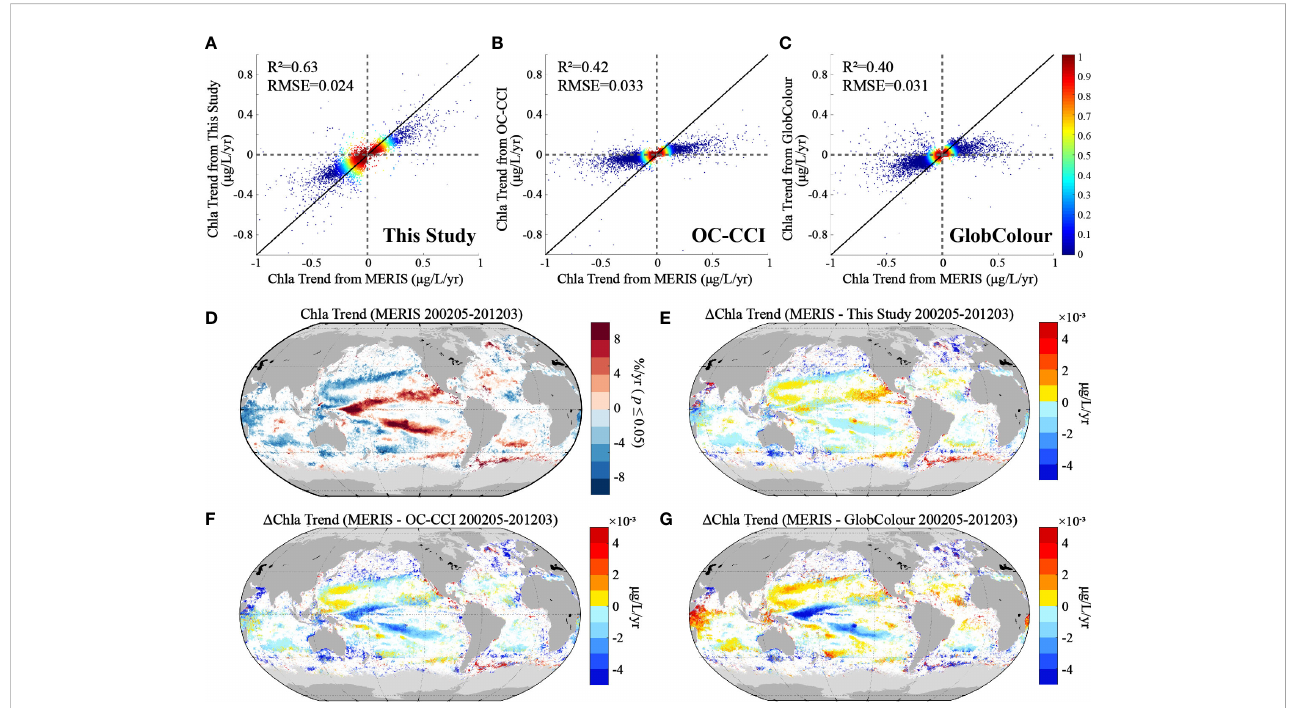
FIGURE 6 Pixel-by-pixel comparison of the Chla rate of change from MERIS and (A) this study, (B) OC-CCI, and (C) GlobColour. (D) Chla trend maps in units of %/yr from MERIS for May 2002 to March 2012. (E – G) Chla trends from MERIS minus that from the three merged datasets in units of m g/L/yr. Black lines on the scatter plots represent the 1:1 line, and the color scale indicates the data density in pixels. The bright gray on the maps represents insuf fi cient data for estimating a trend (i.e., the number of valid data collected in the statistical period (60 months) does not reach 50%), and white indicates that the MERIS data show that the pixel has not changed signi fi cantly ( p <